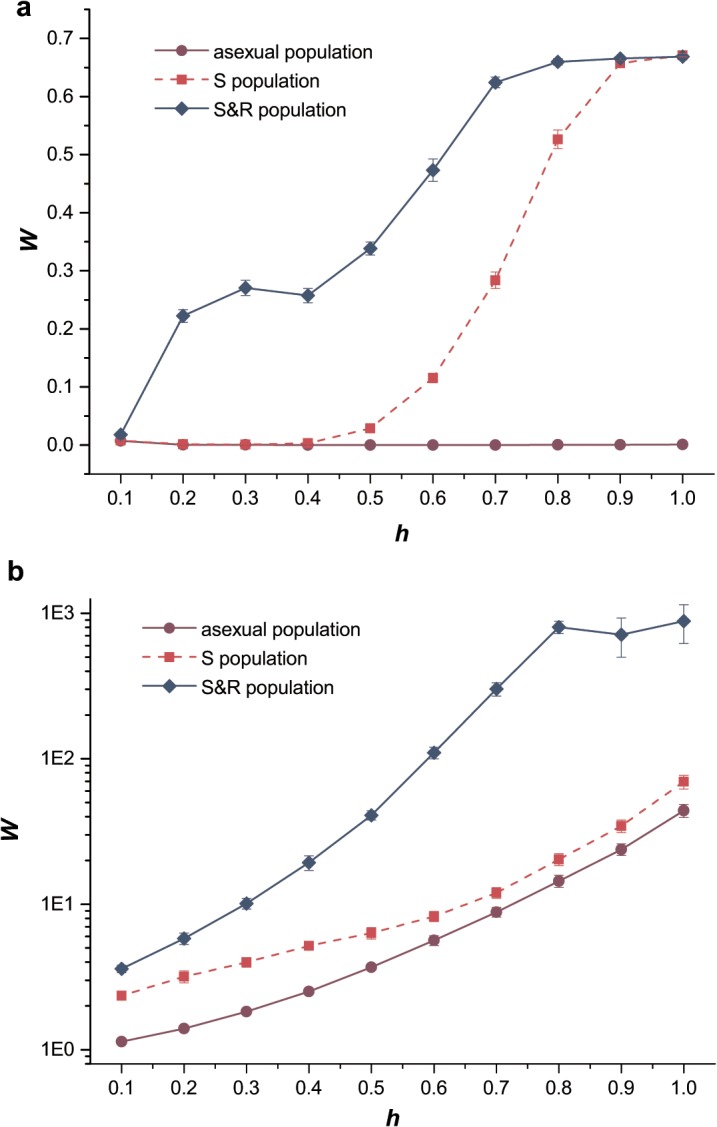
The mean fitness of populations.Purple circles, solid lines, asexual population; red squares, dashed lines, sexual population with only segregation; blue diamonds, solid lines, sexual population with both segregation and recombination (L = 0.01). (a) The mean fitness, W, of each population as a function of dominance coefficient of deleterious mutations h when mutations were exclusively deleterious. U
D = 0.2, s
D = 0.05. (b) The logarithm W as a function of h when mutations were exclusively beneficial. U
B = 0.002, s
B = 0.02. All the populations have the same size N = 10,000. Error bars are the standard error over the 10 averages here and throughout the article.